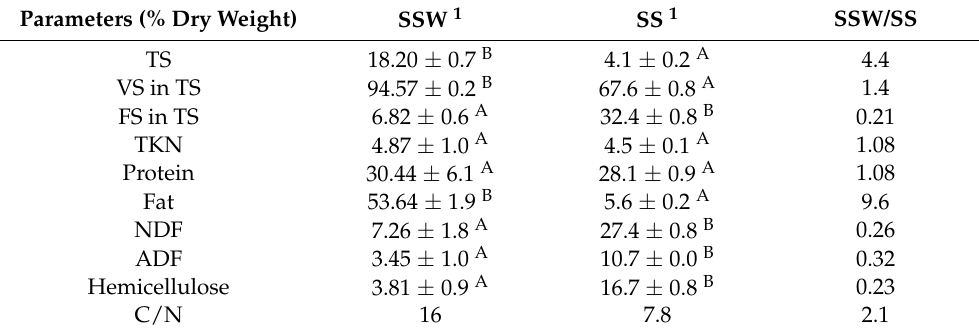
Table 3. Characteristics of SSW and